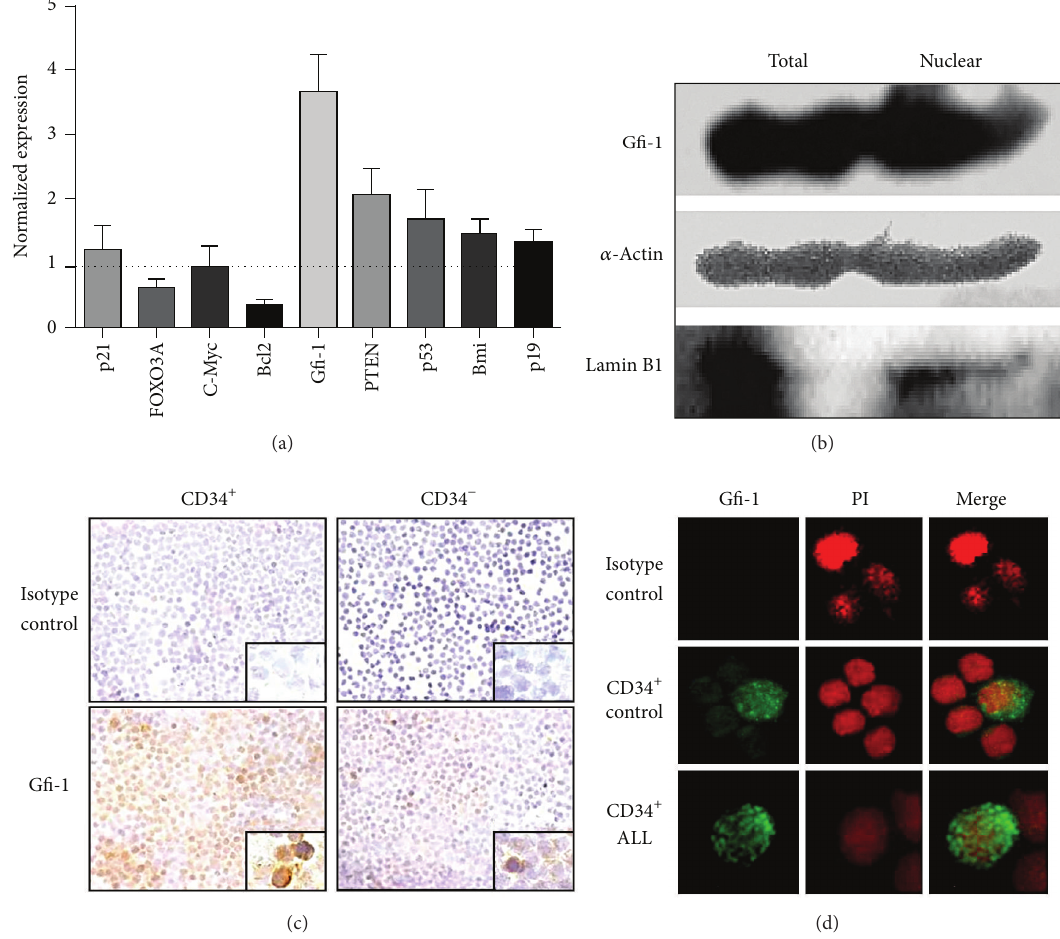
Figure 4: The transcriptional repressor growth factor independence-1 (Gfi-1) is highly expressed in progenitor cells from leukemic individuals. A number of transcription factors and cell cycle genes, including p21, FOXO3A, c-Myc, Bcl2, Gfi-1, PTEN, p53, Bmi, and p19, were investigated by real time RT-PCR in Lin − CD34 + cells from ALL BM, and their expression values normalized to control cells (a). The protein production of the transcriptional repressor Gfi-1 (45kDa) was demonstrated in both nuclear and total extracts from ALL CD34 + cells by Western blotting. As loading control protein and as nuclear protein marker, 𝛼 -actin (43kDa) and LaminB1 (67kDa) were included, respectively (b). Immunocytochemistry approach showed the highest protein expression of Gfi-1 in precursor CD34 + cells (c), where the nuclear location was confirmed by immunofluorescence microscopy